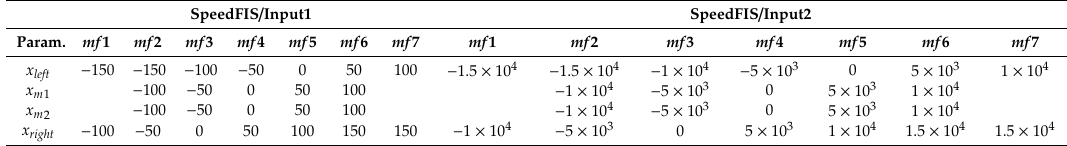
Table 2. Parameters of the mf for the both inputs of the “SpeedFIS”.